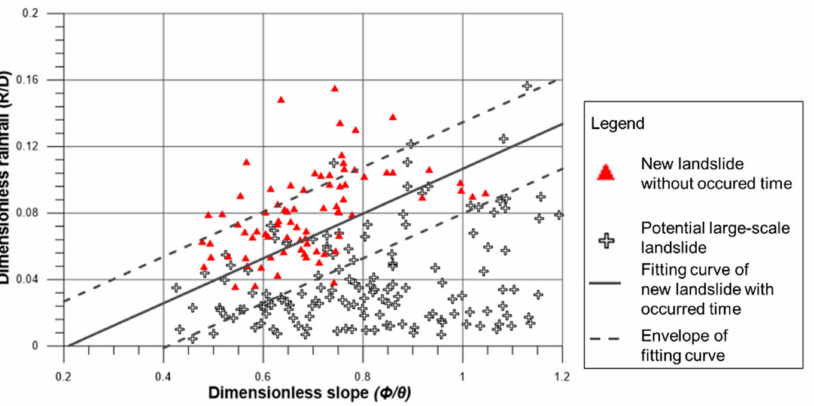
Figure 10. Relationship between envelope of fitting curve and new landslides case and potential